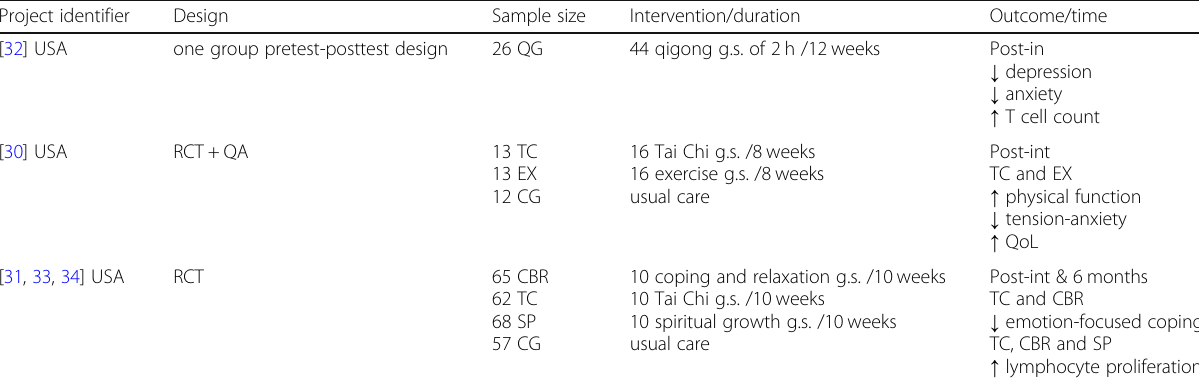
Table 2 Tai Chi and Qi gong included studies Project